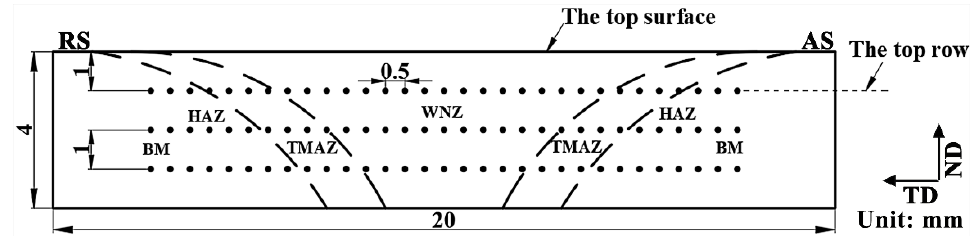
Figure 3. Schematic map of the measurement of Vickers micro-hardness. The distance between the top row and the top surface is 1 mm, and the distance between the adjacent rows is 1 mm. The interval between two points is 0.5 mm. Transverse direction perpendicular to the welding direction is marked as TD. The direction along the thickness of the joint is called the nominal direction and marked as ND.